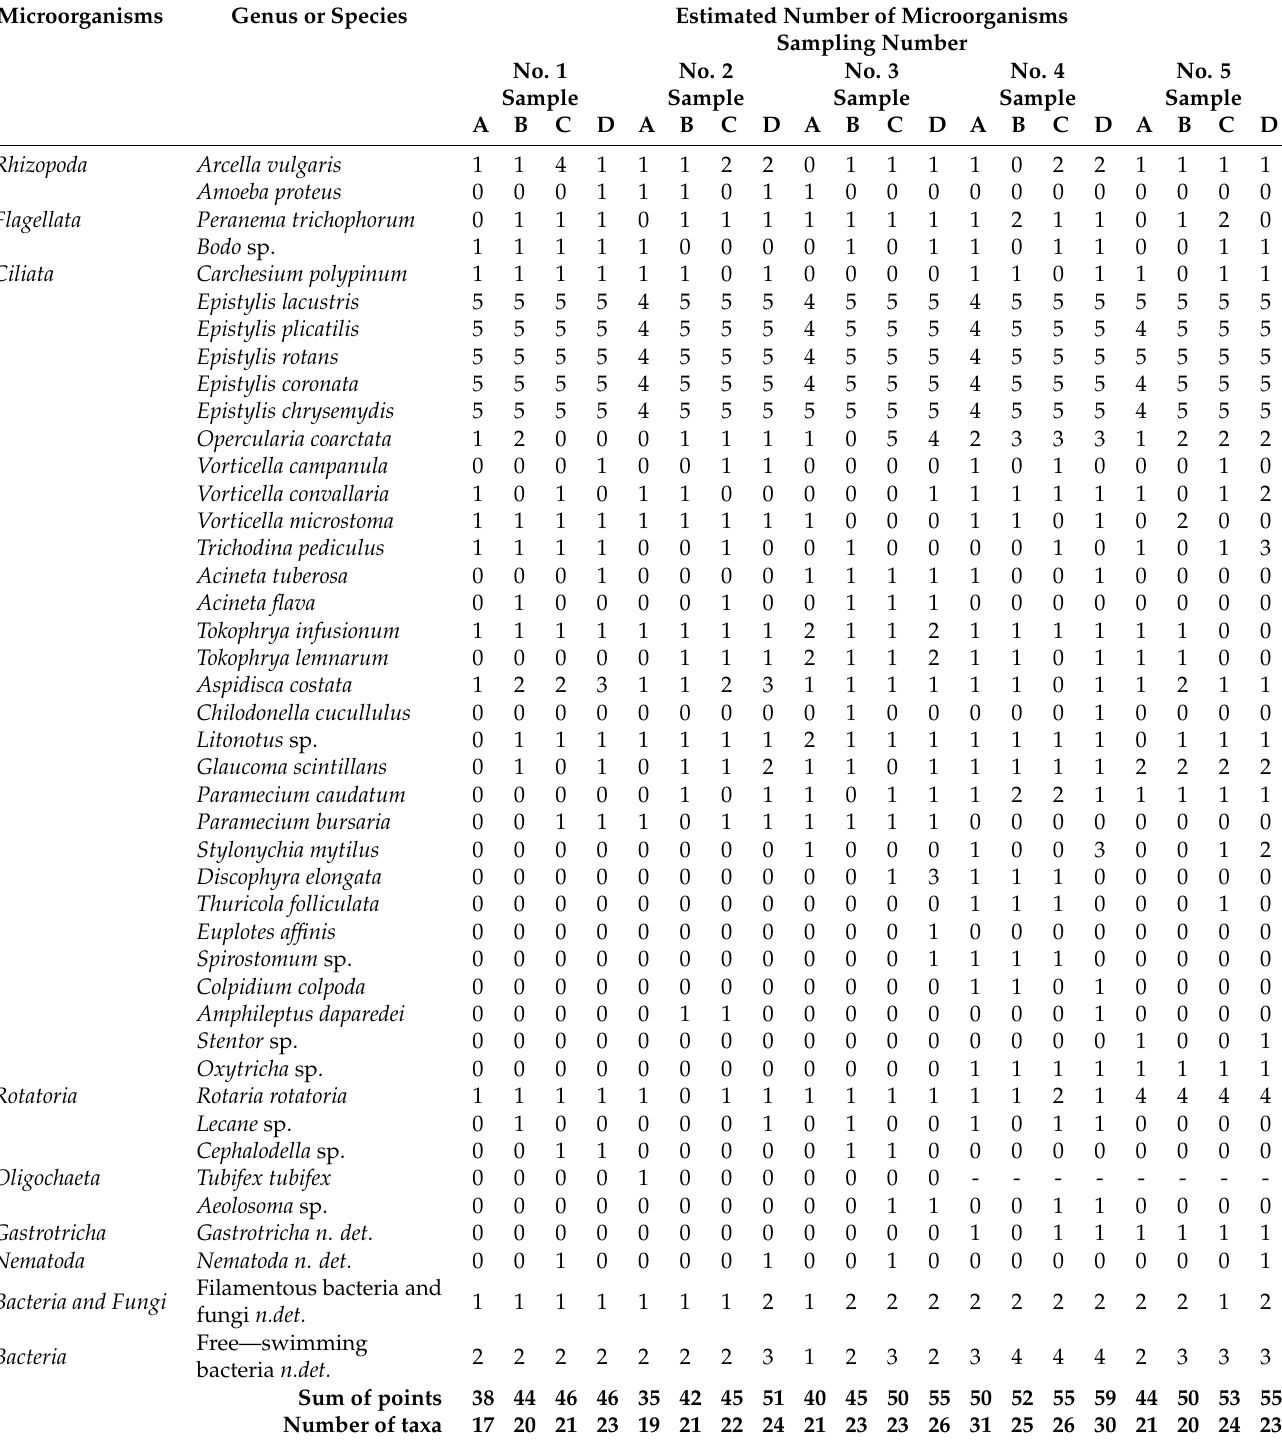
Table 6. Estimated number of microorganisms on the